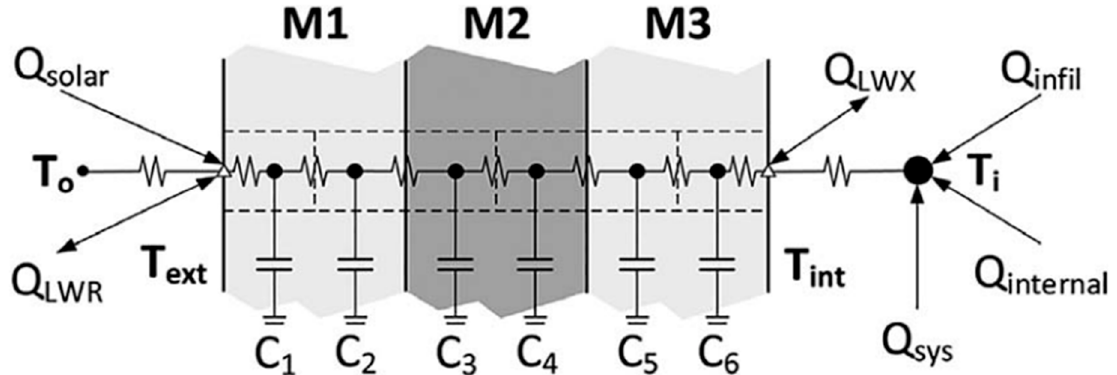
Figure 2. 3R2C network to model the heat transfer through an exterior wall.